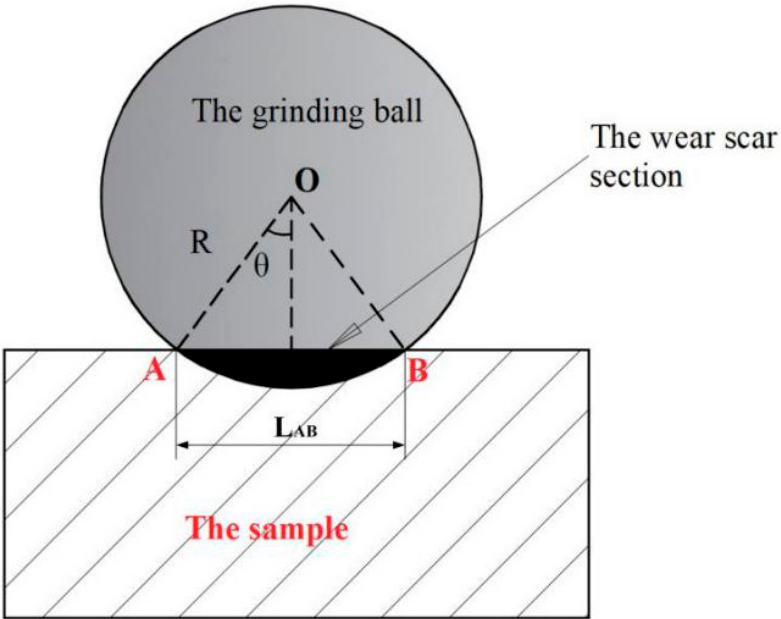
Figure 3. Schematic diagram of the wear volume calculation. O is the center of the ball; R is the radius of the sphere; θ is the center half angle corresponding to the width of the grinding mark; L AB is the width of the grinding mark.